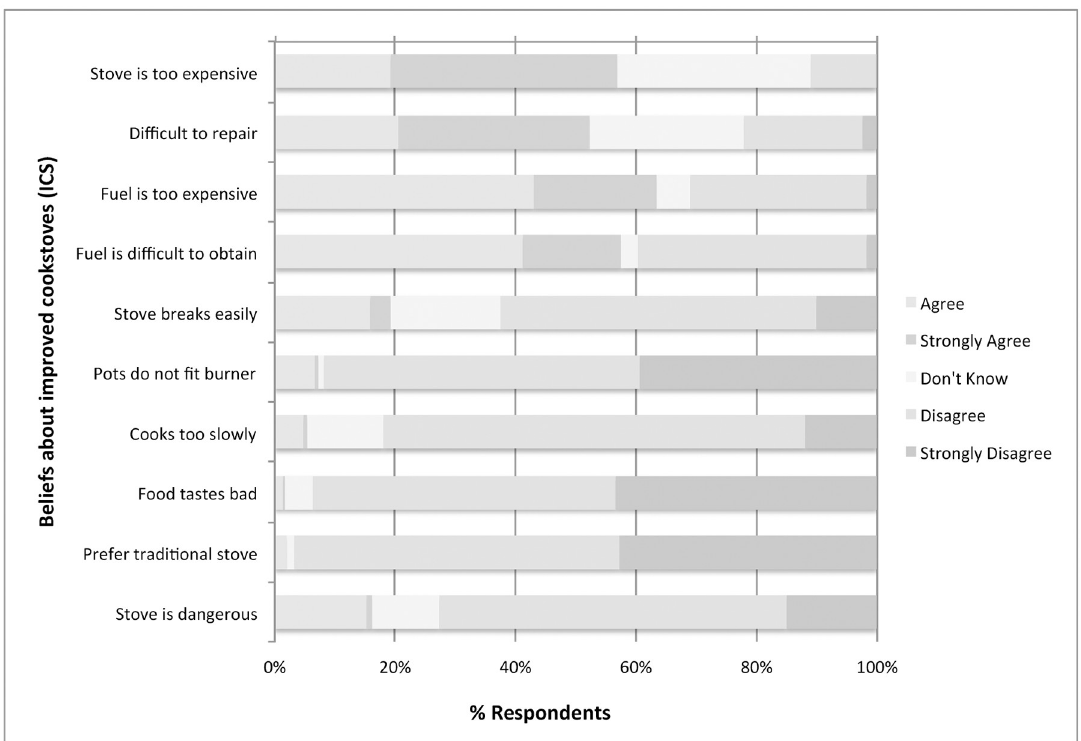
Fig 4. Likert scale presentation of perceptions of improved cookstoves